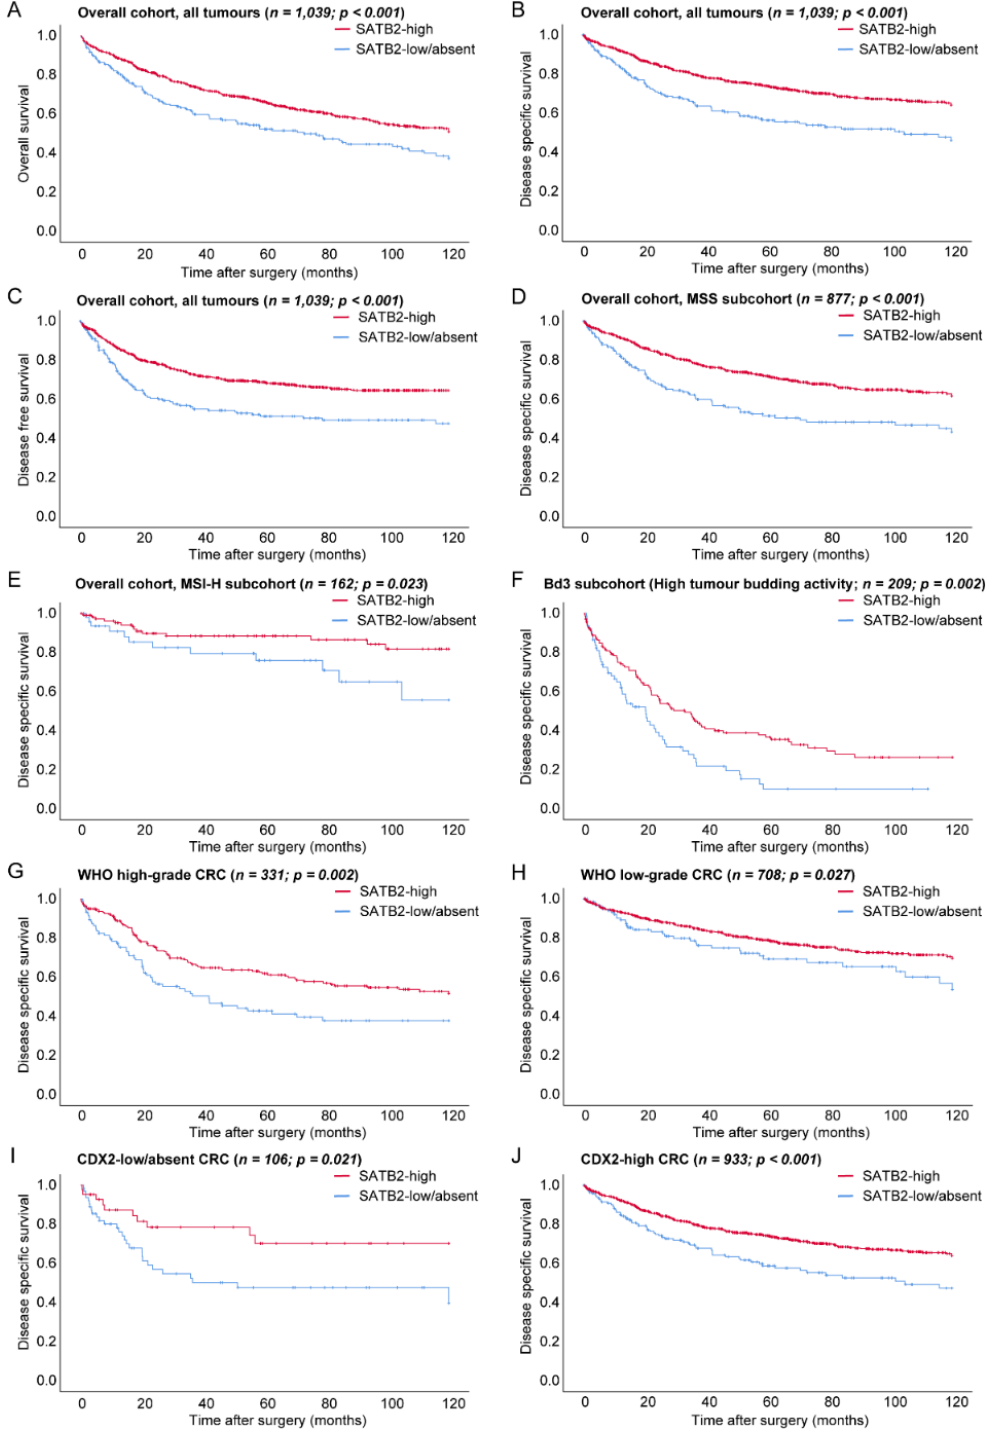
Figure 3. Prognostic relevance of SATB2 expression in univariate analyses on overall-, disease specific- and disease free-survival in the overall cohort ( A – C ) and for disease-specific survival in specific CRC subgroups: MSS ( D ) and MSI-H ( E ) subcohorts, high tumour budding activity subcohort ( F ), WHO high-grade ( G )/WHO low-grade ( H ) subcohorts, CDX2-low/absent ( I )/CDX2-high ( J )